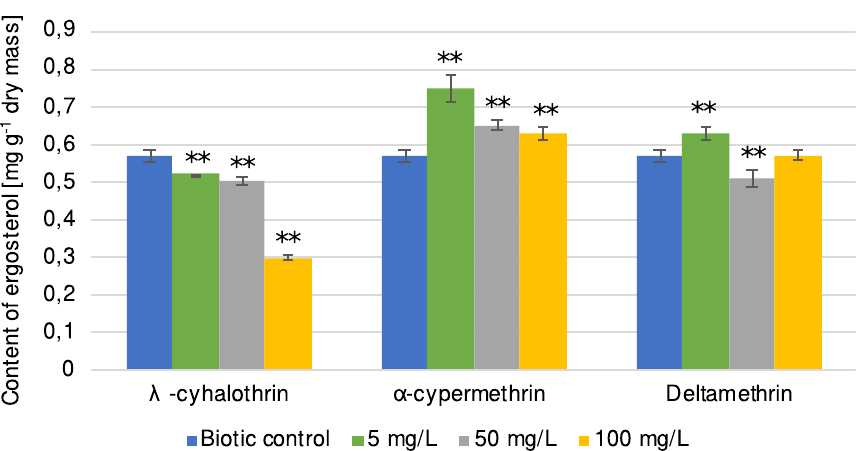
Figure 1. Content of ergosterol [mg g −1 dry mass] in the B. bassiana cells after 48 h of cultivation with λ-cyhalothrin, α-cypermethrin, and deltamethrin. All samples were prepared in triplicate, and the experiments were repeated twice. Results were tested by one-way ANOVA; significance: ** P < 0.01, * P <